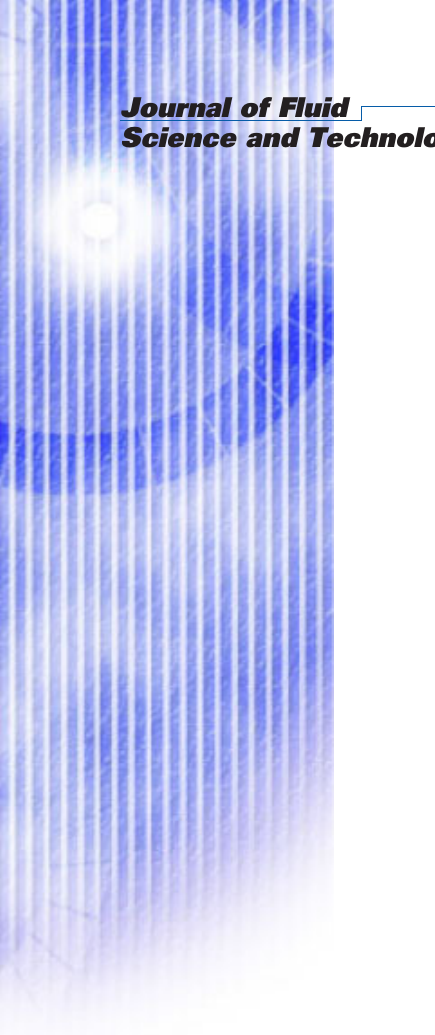
Fig. 8 (a) The time series of the measured pressure di ff erence P m and P h given by Eq. (5). (b) The di ff erence between the flow rate Q m given by Eq. (1) adopting the measured pressure P m and the flow rate Q h given by Eq.